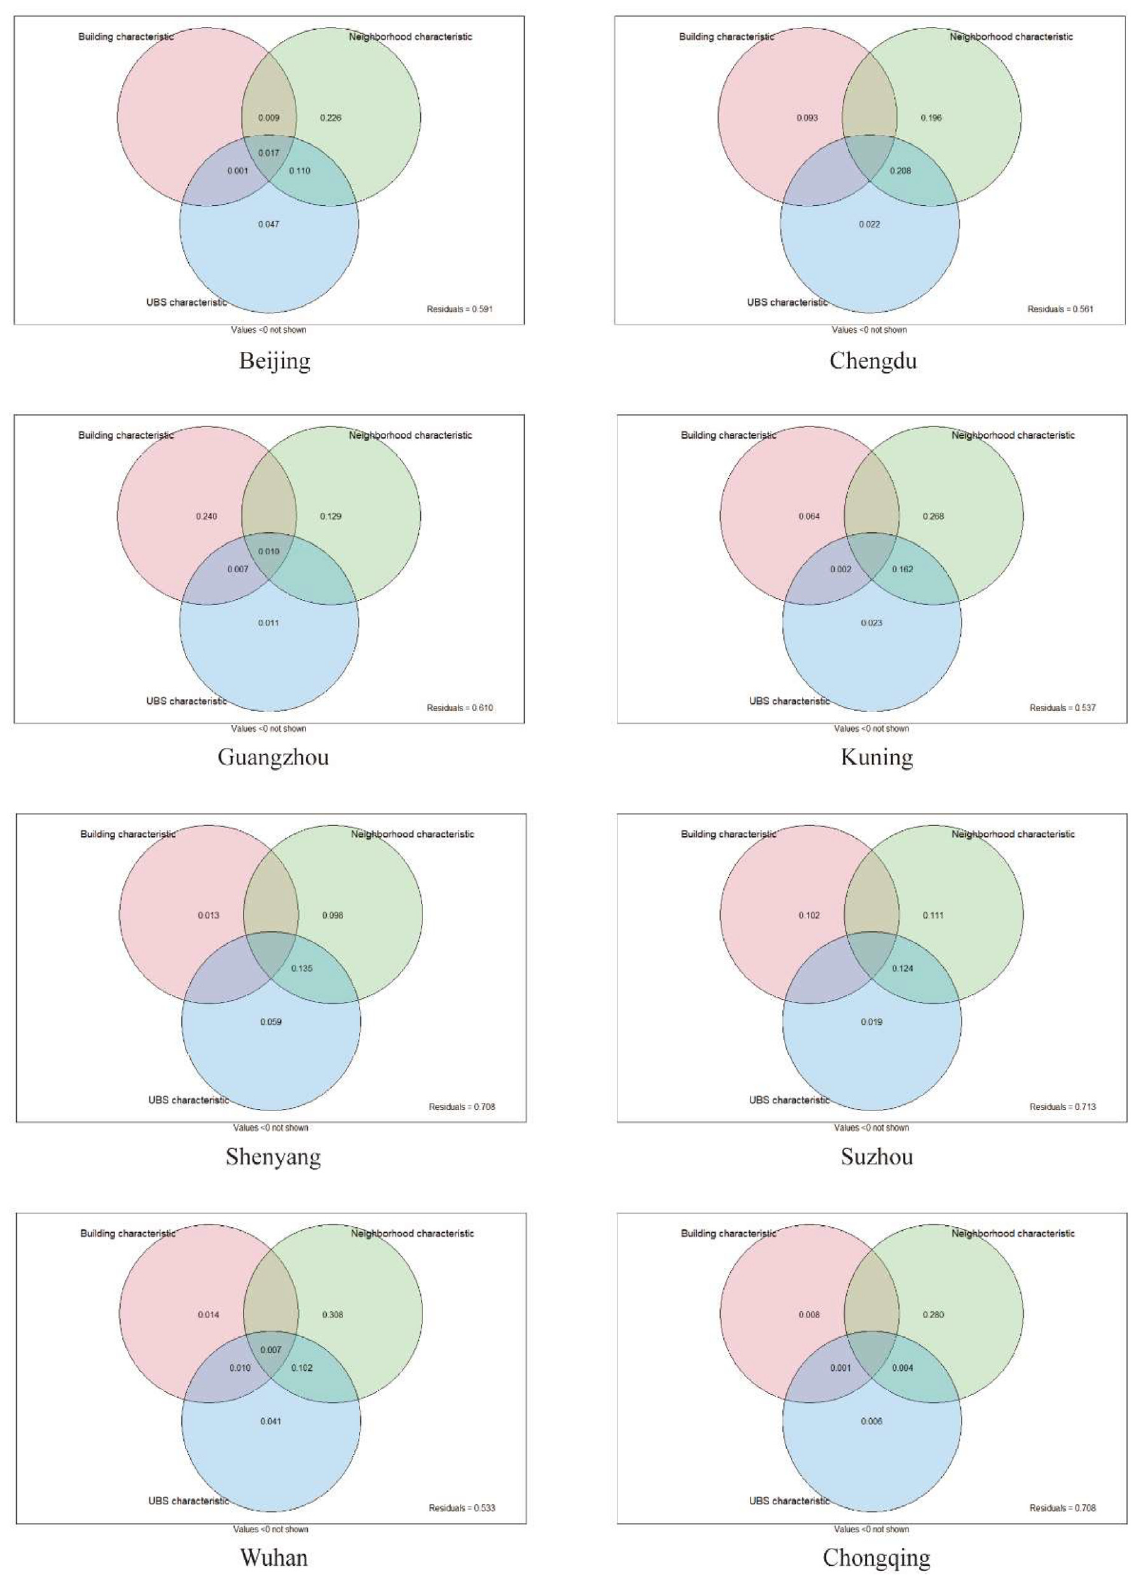
Figure A1. Variance partitioning analysis results for Model I.